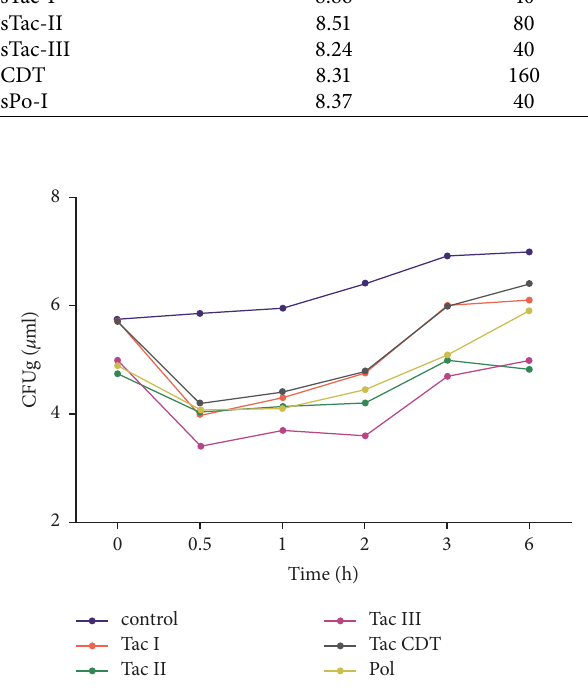
Figure 1: Time-kill curves depicting the antibacterial activity of the fve sLAMPs against LM.